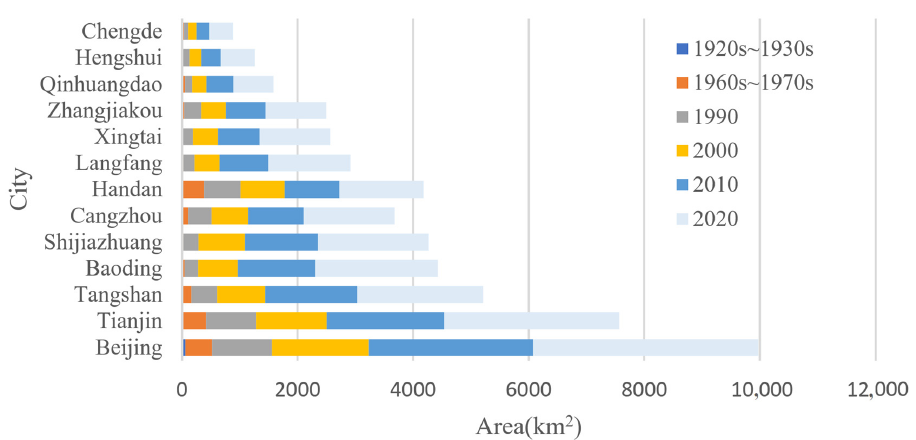
Figure 6. Change in the area of urban built-up areas of major cities in the BTH region.